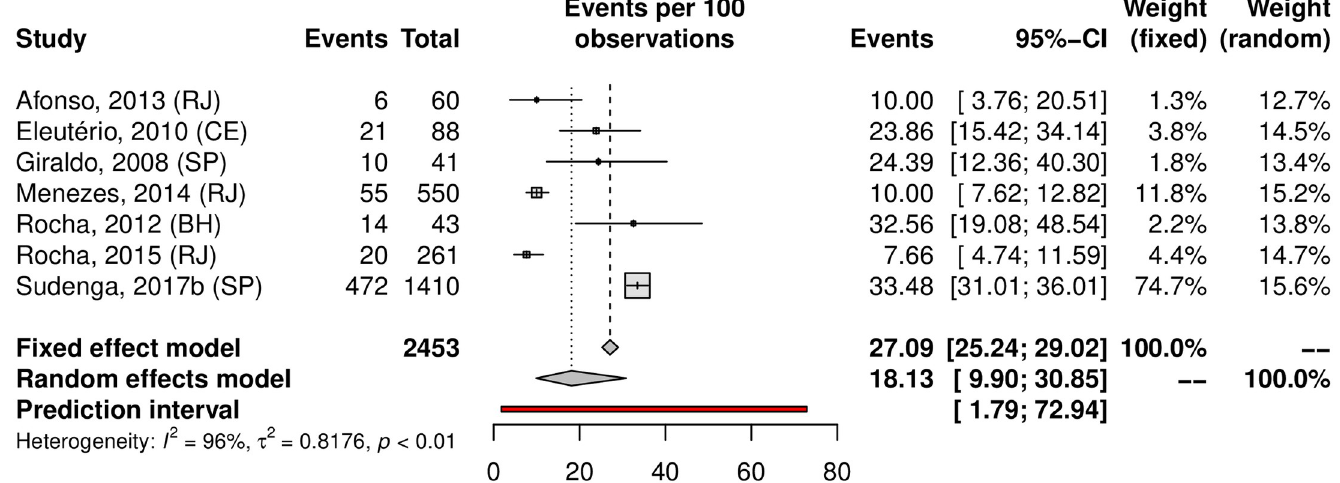
Fig 13. Overall prevalence of penile infection by high-risk HPV genotypes. Forest plot of a metanalysis of studies reporting prevalence of penile infection by HR-HPV genotypes in Brazil.